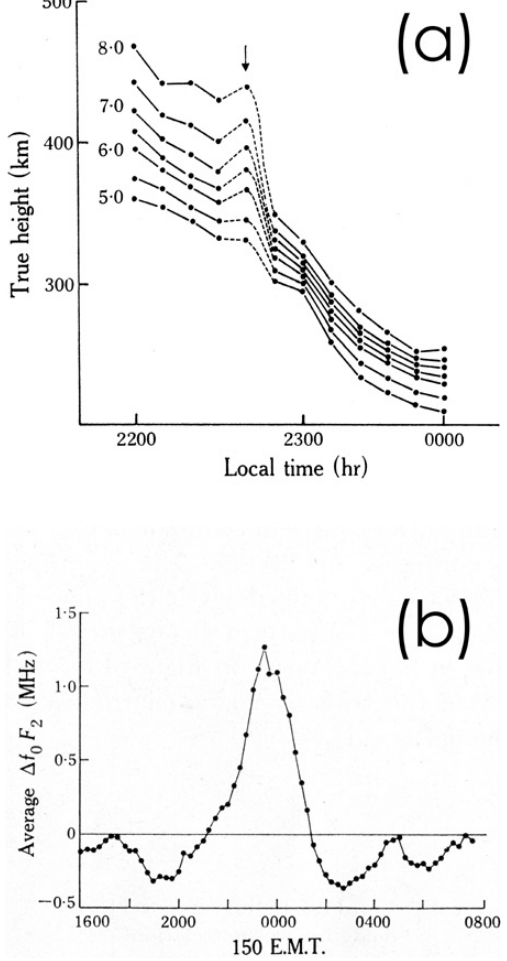
Fig. 3. From Khan (1970) reproductions of (a) Fig. 8 showing height changes and (b) Fig. 12 involving fo F2 changes, both (a) and (b) associated with the LS-TID, shown by Fig. 2b.